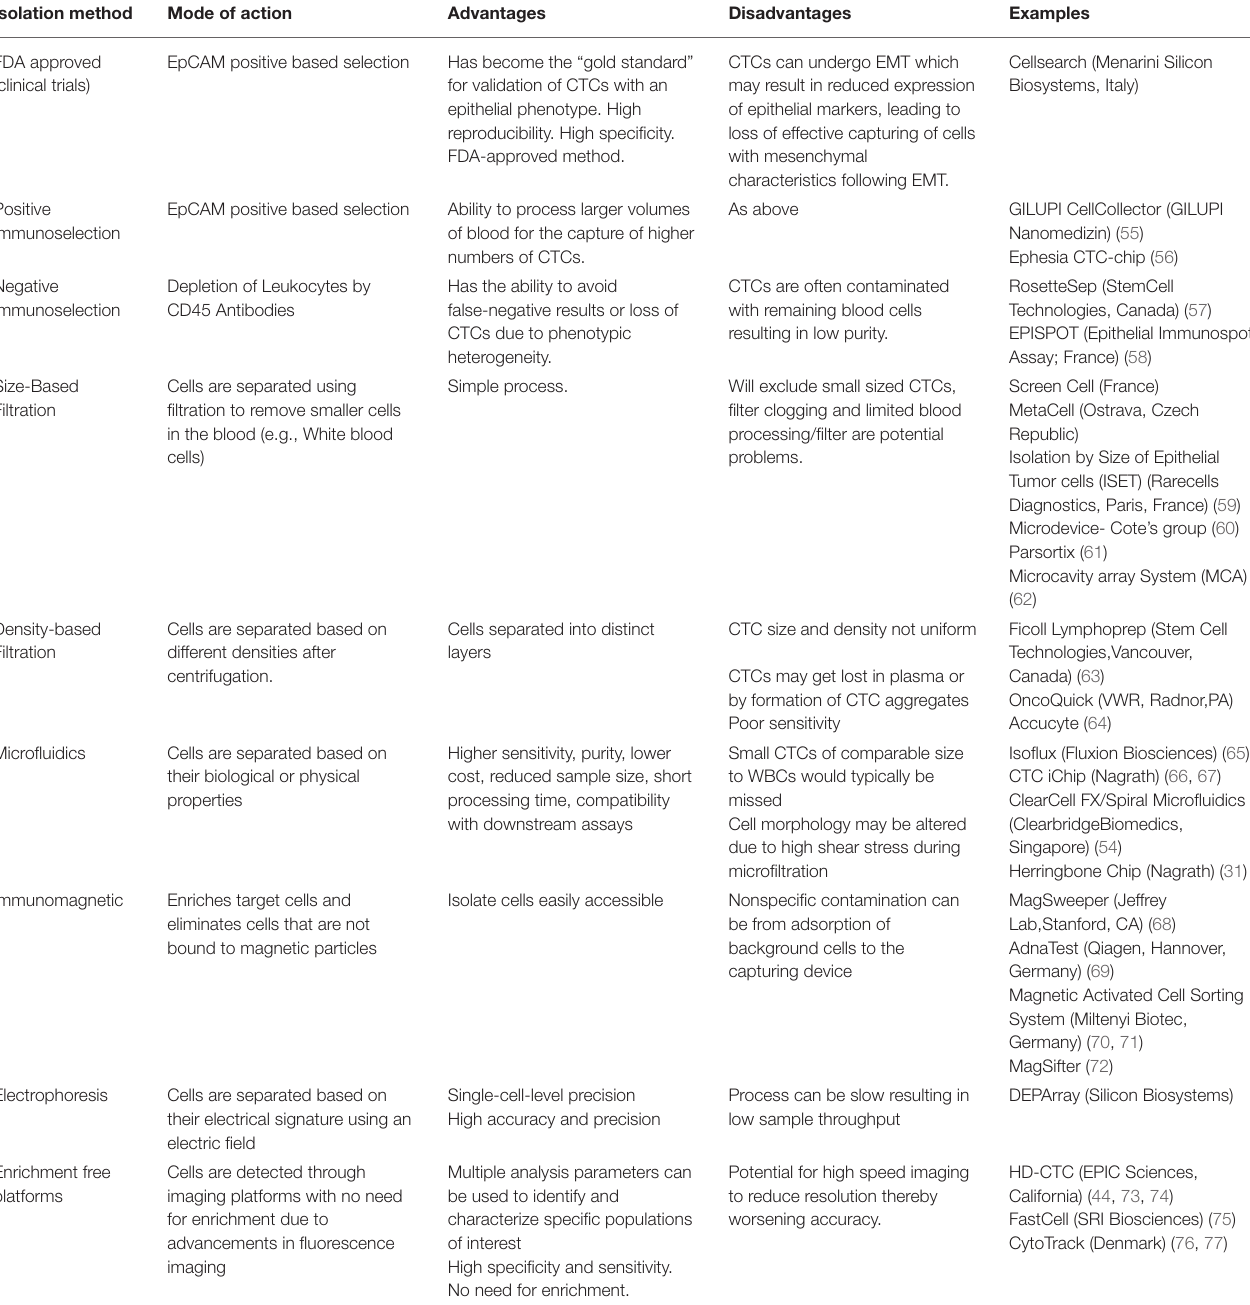
TABLE 2 | The Summary of different Circulating Tumor Cell isolation methods currently used in